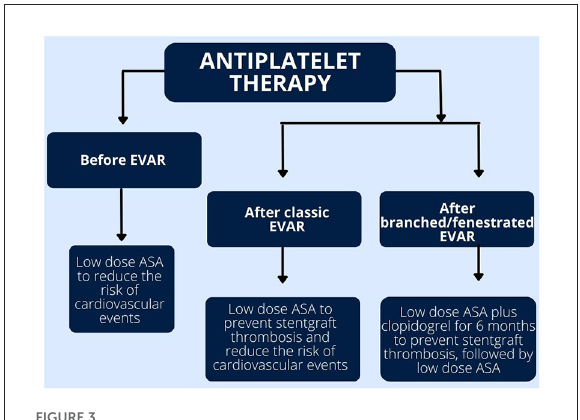
FIGURE3 Summary of antiplatelet therapy before and after endovascular aneurysm repair